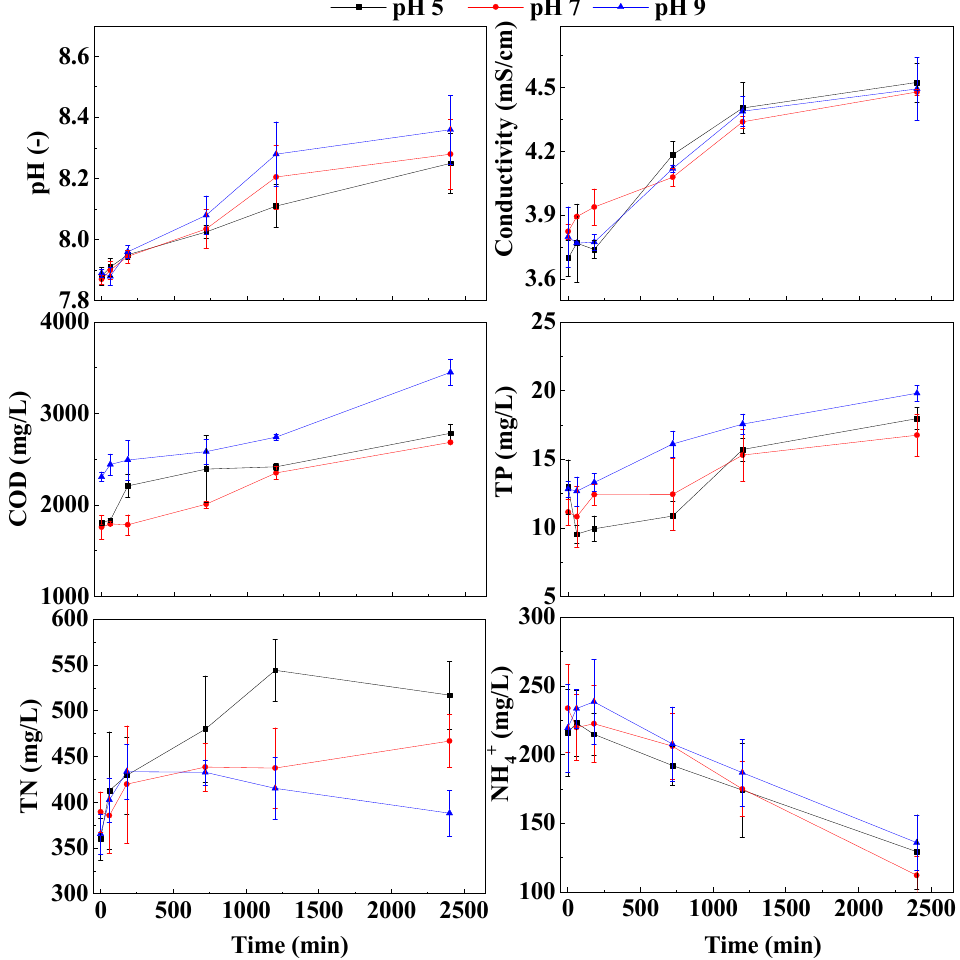
Figure 3. Effect of draw solution pH on basic properties and nutrients of biogas slurry during FO membrane concentration processes.